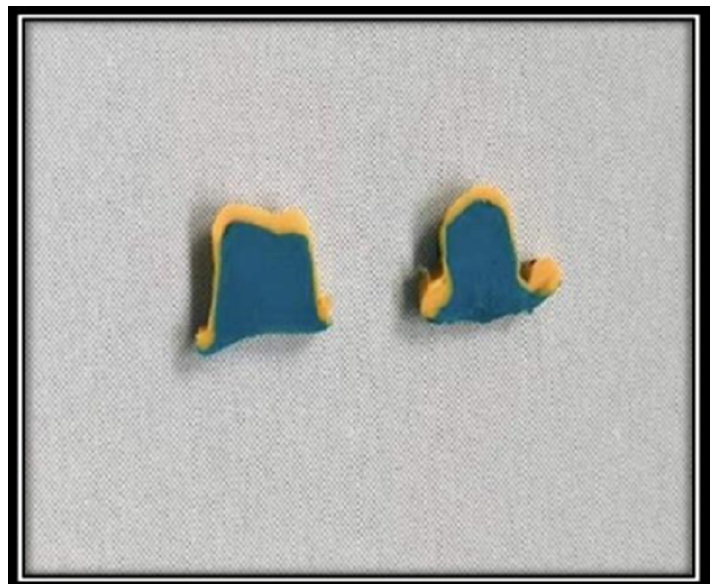
Figure 5. Buccolingual and Mesiodistal sectioned replica.